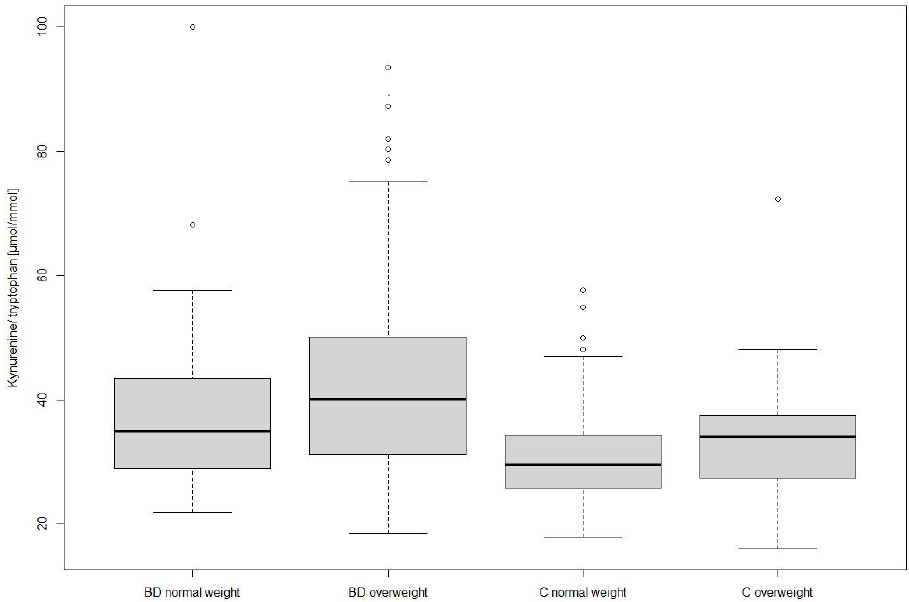
Figure 1. Kynurenine to tryptophan ratio in individuals with bipolar disorder (BD) and controls (C) with normal and overweight .